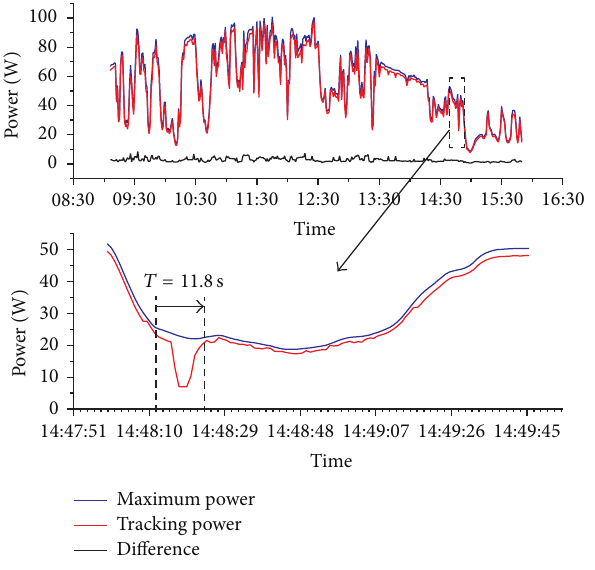
Figure 11: MPPT controller’s tracking results under rapidly changed solar strength.